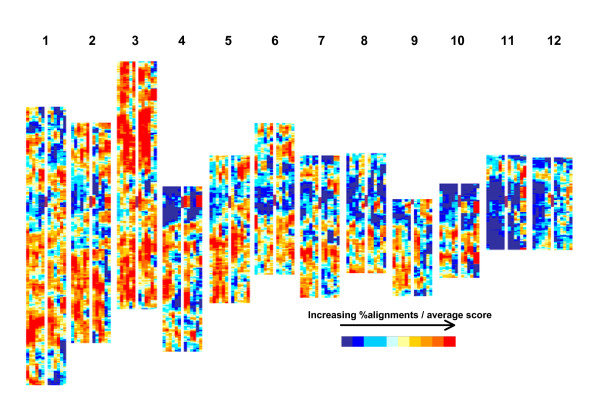
Heat maps for % sequence alignments and average scores. Colour coded moving windows/100 functionally annotated, expressed TIGR rice loci (MWs/FAexpTRL) for each rice pseudomolecule (1–12). For each pseudomolecule: column 1–6 = MWs for % significant MegaBLAST alignments between Os_CD and test databases Lp_MF, Zm_MF, Zm_TA, Hv_TA, Gm_TA and At_TA respectively; column 7 = position of MWs containing rice centromere (dark vertical bar); column 8–13 = MWs for average score of significant MegaBLAST alignments between Os_CD and test databases Lp_MF, Zm_MF, Zm_TA, Hv_TA, Gm_TA and At_TA, respectively [see Additional file 2 Table 3 for colour code quantification]. Pseudomolecule representations are aligned along the centromeres.